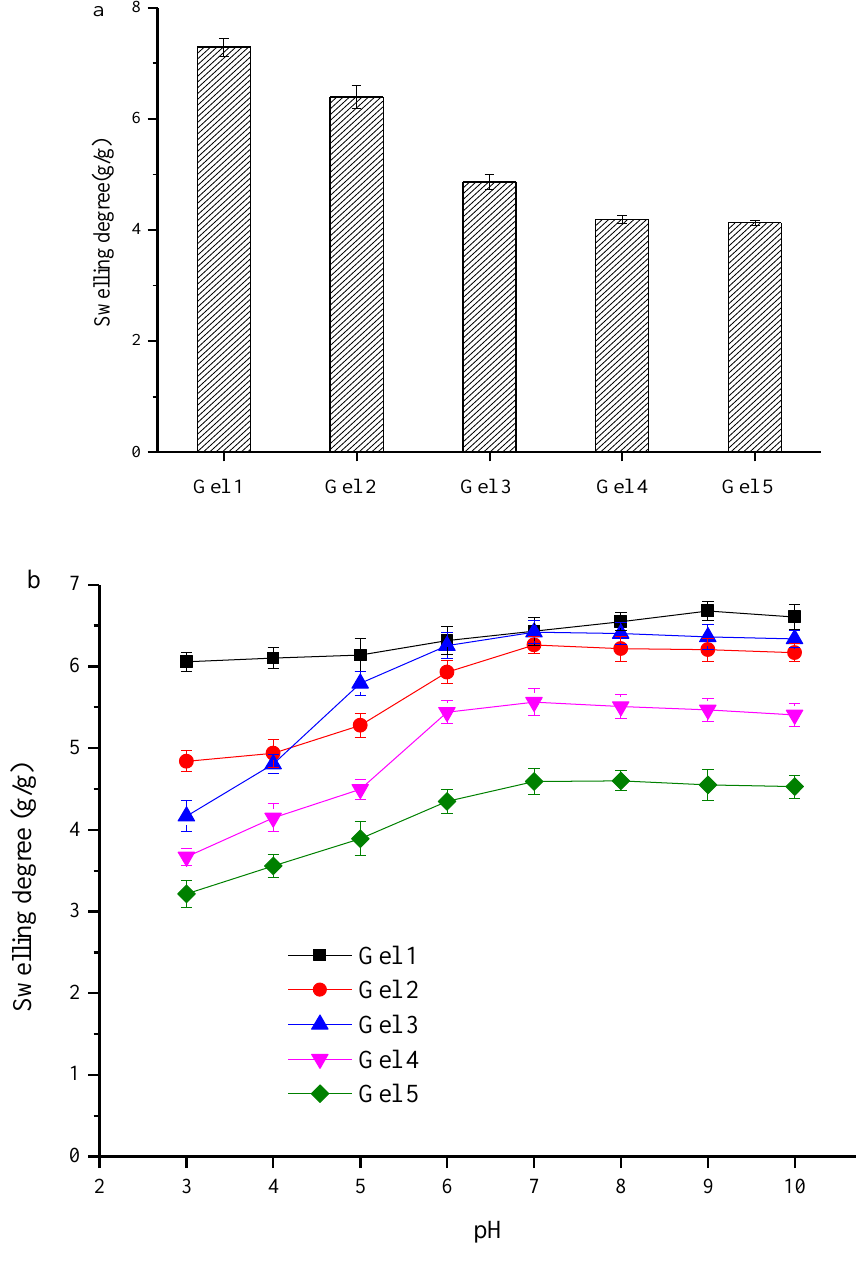
Figure 5. Swelling degree of hydrogel in deionized water ( a ) and different pH buffers ( b ). The pH-responsive behavior of hydrogels was also observable in Figure 6. The volume of Gel 1 was similar at different pHs. However, the volume of Gel 2–5